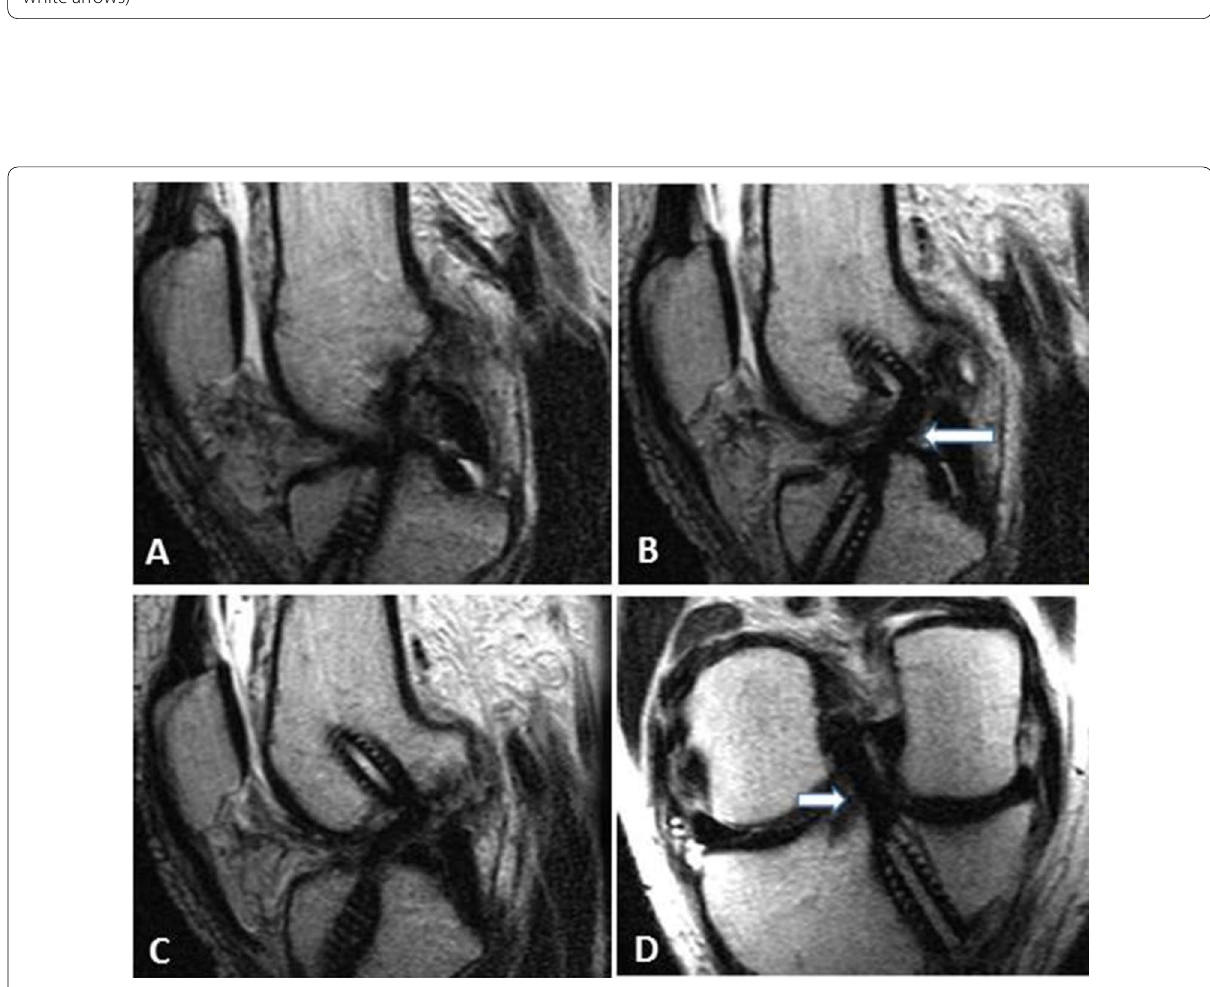
Fig. 8 a , b , c Sagittal oblique T2 WIs and d , coronal oblique T2 WIs (protocol B) of the same patient mentioned in Fig. 7, showing intact (grade 0) graft as a low signal intensity graft with well-preserved continuation and a taut orientation (thick white graft). Arthroscopy confirmed the intact nature of the